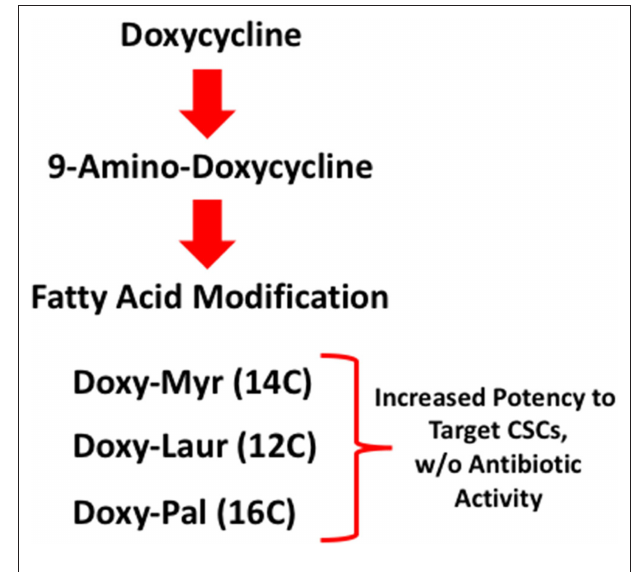
FIGURE 12 | Schematic diagram highlighting our systematic approach to generating Doxycycline derivatives, to target CSCs and prevent metastasis. Lipid moieties were covalently conjugated to 9-amino-Doxycycline. Importantly, these three Doxycycline derivatives lack anti-microbial